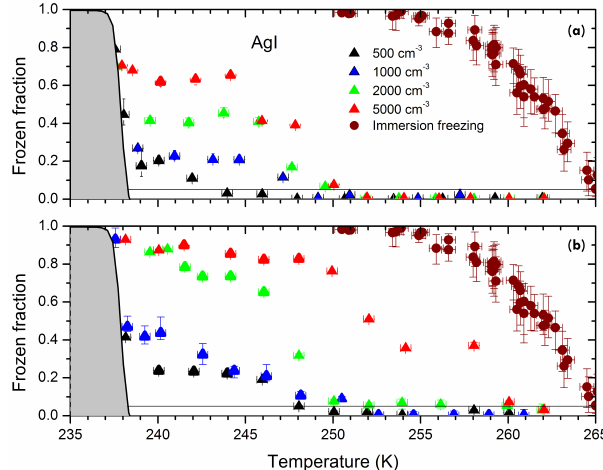
Figure 1. Frozen fraction against chamber temperature for silver iodide particles of 200nm diameter. Contact freezing for aerosol concentrations from 500 to 5000cm − 3 is given by triangles for a droplet residence time of 2s in panel (a) and 4s in panel (b) . Im- mersion freezing for a 3s residence time of droplets in the ZINC chamber is shown by circles. The gray shaded area shows the ho- mogeneous freezing of droplets determined from blank experiments (without aerosol) and the black horizontal line indicates the lower reliability limit of the measurements determined from the blank sig- nal level observed in experiments without aerosol. Error bars repre- sent the uncertainty in the frozen fraction due to the classification (liquid or ice) uncertainty of the IODE detector (Lüönd et al.,